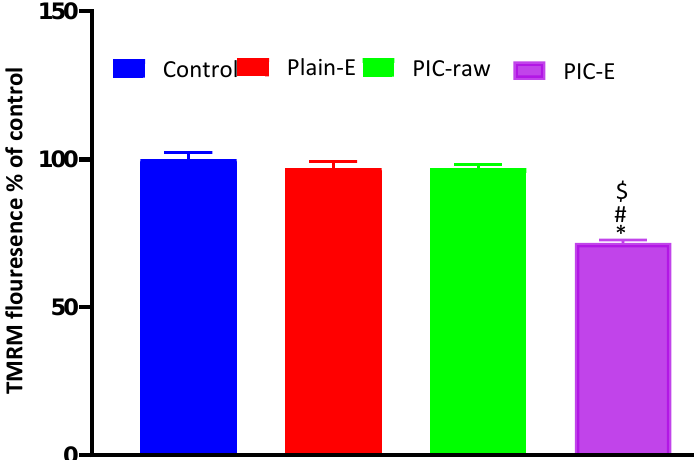
Figure 8. Effect of PIC-E on MMP in HCT 116 cells. Cells were incubated for 24 h with plain-E, PIC- raw (0.1 µM), or PIC-E (equivalent to 0.1 µM PIC) * Significantly different from control at p < 0.05. # Significantly different from plain-E at p < 0.05. $ Significantly different from PIC-raw at p < 0.05.